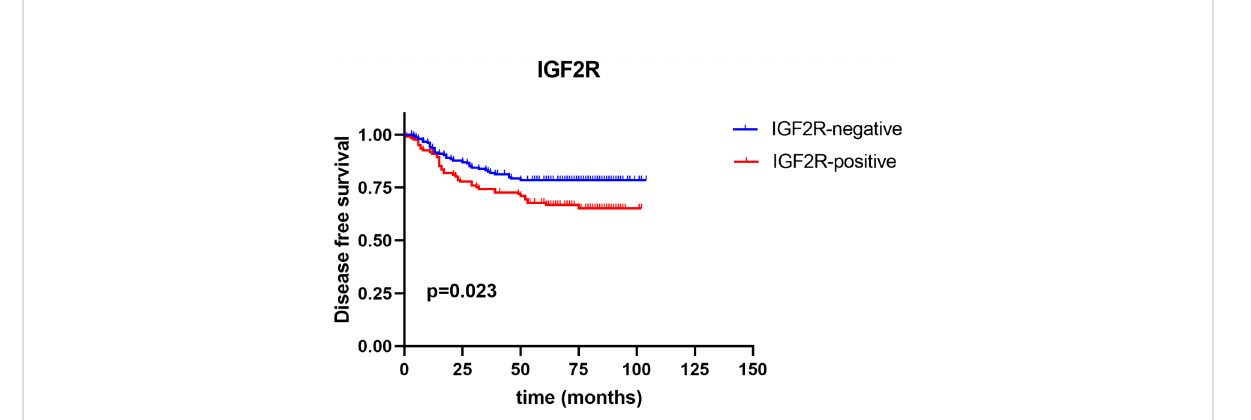
FIGURE 5 Disease-free survival between IGF2R-positive patients and IGF2R-negative patients in the TNBC